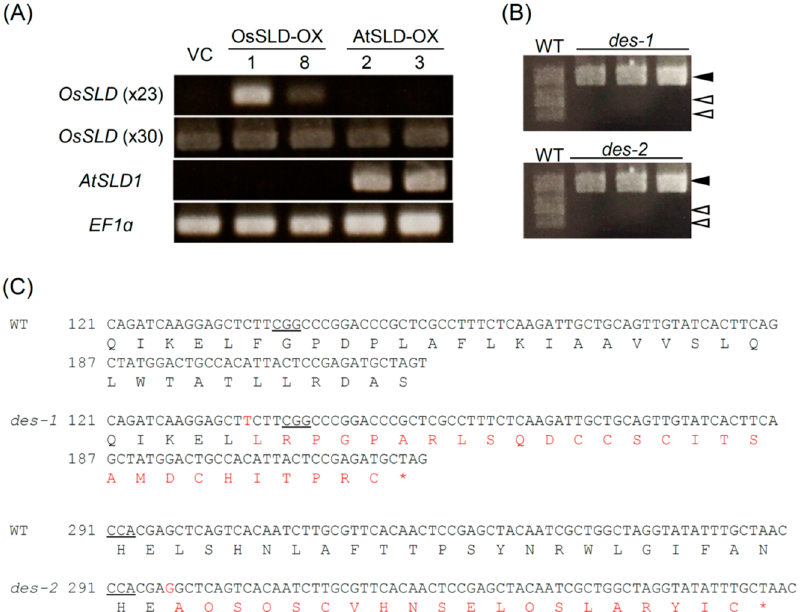
Figure 2. Characterization of transgenic rice plants. ( A ) RT-PCR analysis of OsSLD and AtSLD1 in OsSLD-OX and AtSLD-OX lines. EF1 α was used as a reference gene. The OsSLD amplicon was detected in only OsSLD-OX plants at 23 cycles of PCR but in all lines at 30 cycles. AtSLD1 was never amplified except for AtSLD-OX. VC—vector control. ( B ) Restriction digestion of genomic PCR products including CRISPR / Cas9 target sites for OsDES in des-1 and des-2 plants. Closed and open arrowheads indicate non-digested PCR products and cleaved fragments, respectively. ( C ) Nucleotide and deduced amino acid sequences of OsDES cDNA. Red-colored letters show altered sequences in the mutants. An asterisk shows the stop codon. PAM sequences (NGG) are